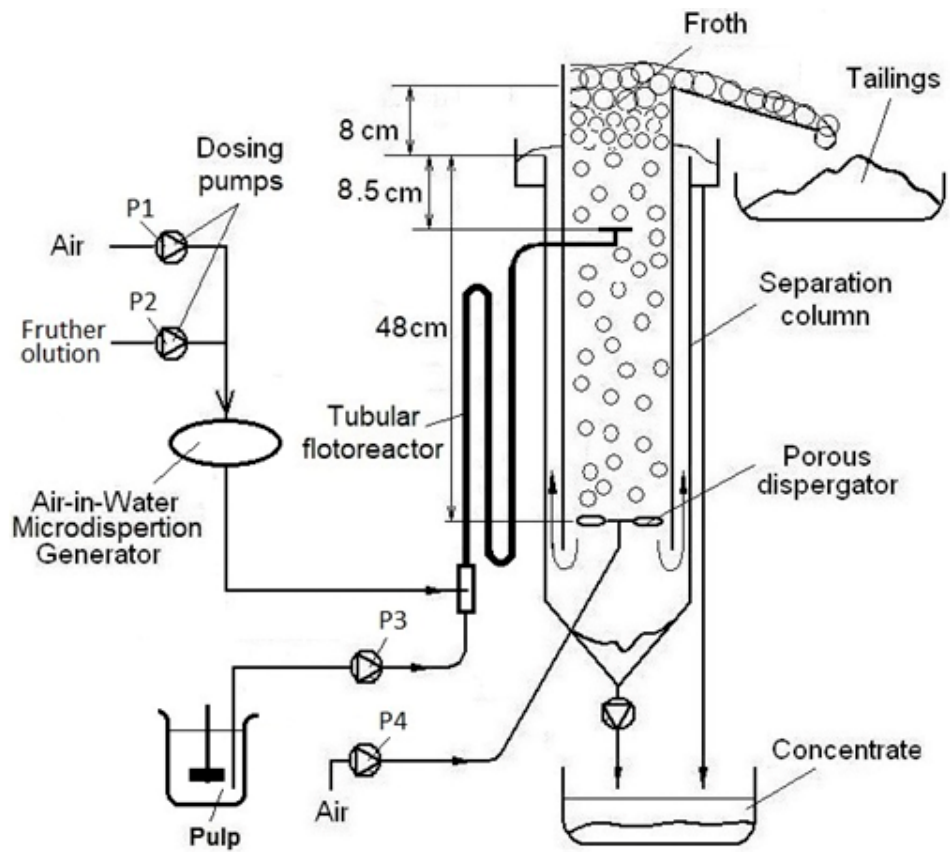
Figure 1. Laboratory rig layout for studying the process of the column flotation.